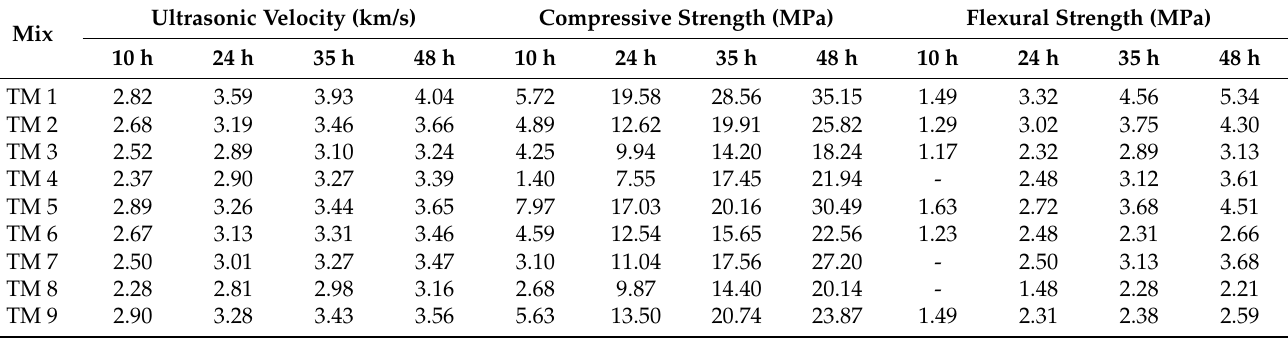
Table 3. Ultrasonic velocity and compressive and flexural strength